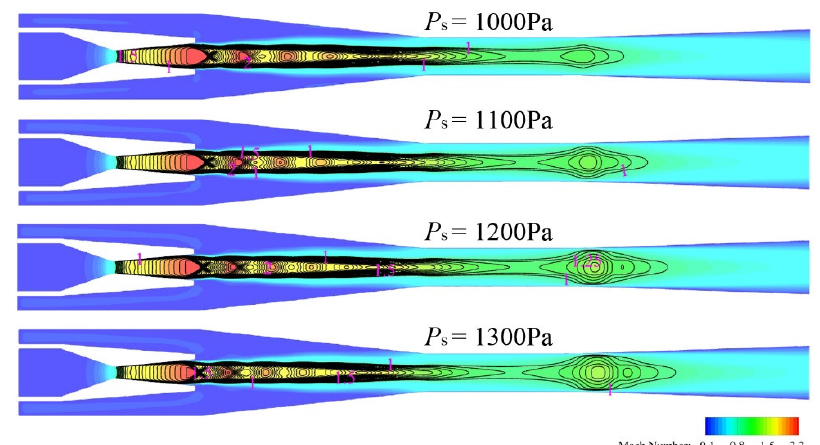
Figure 10. Ma counters with different P s .